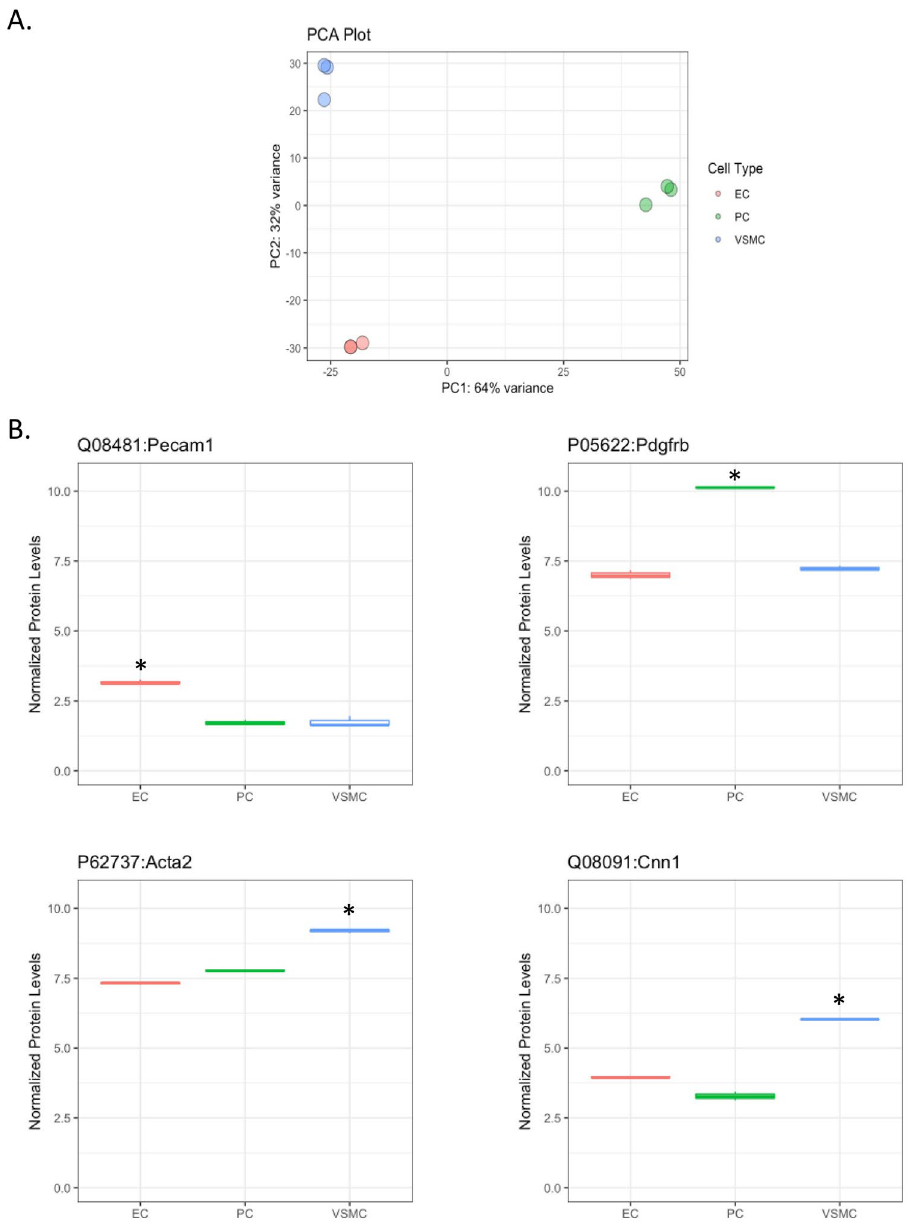
Figure 4. Proteomic analysis shows three distinct cell populations. ( A ) PCA plot showing three distinct and reproducible cell populations upon global proteomic analysis of cultured ECs, PCs, and VSMCs, n = 3. ( B ) Boxplots (median, interquartile range), of proteomic analysis of cell-specific markers. Values were filtered based on FDR rate < 0.05 and then log fold change values compared to the other cell types, n = 3, * p < 0.05, compared to both other cell types (R software package